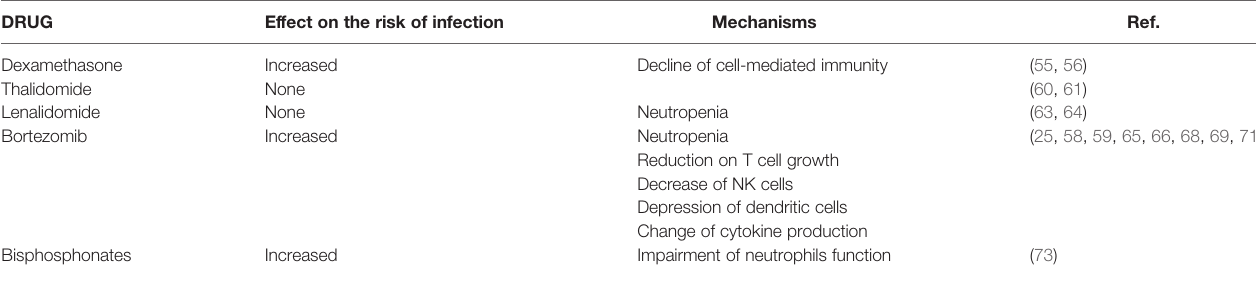
TABLE 1 | In fl uence of the therapeutic treatment of multiple myeloma on the onset of infections. DRUG Effect on the risk of infection